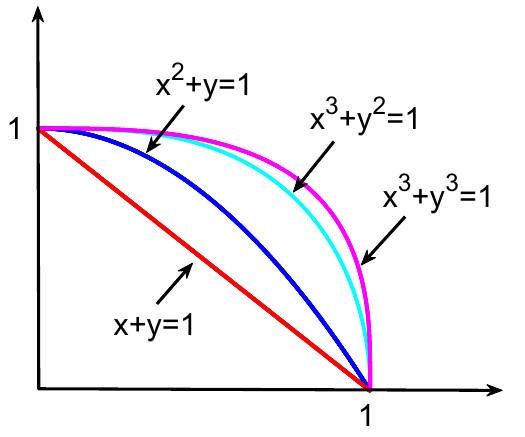
Fig. 1 The grades space of (2,1)-FSs